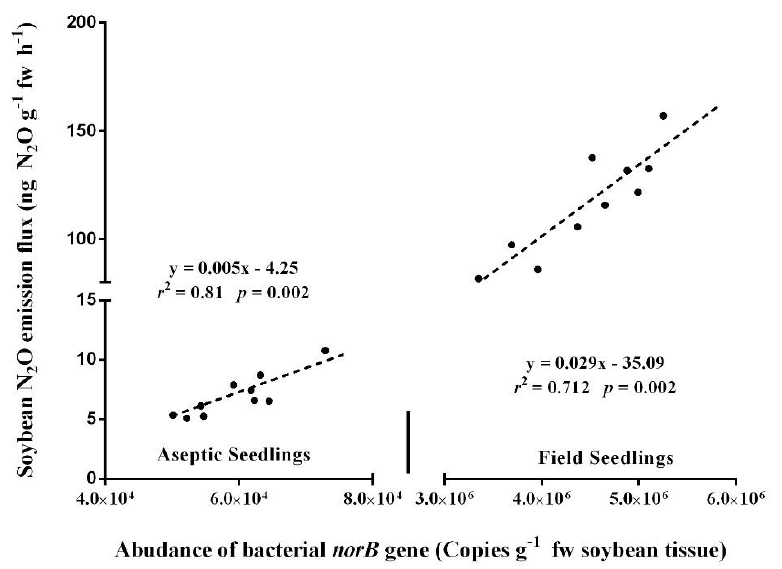
Figure 4. Relationships between plant N 2 O flux (ng N 2 O g − 1 fw h − 1 ) and endophytic nor gene abundance (copies g − 1 fw soybean tissue), correlation analysis were respectively performed in the field group and aseptic group.